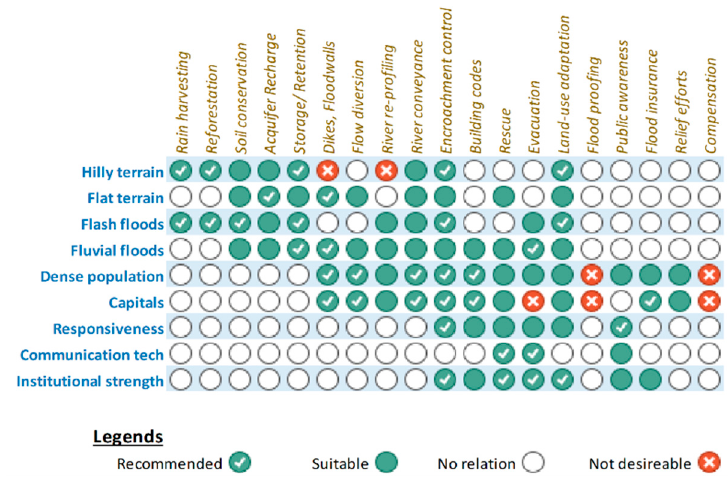
Figure 3. A typical example of a short-listing matrix (SLM) for flood management options (source: [51]).